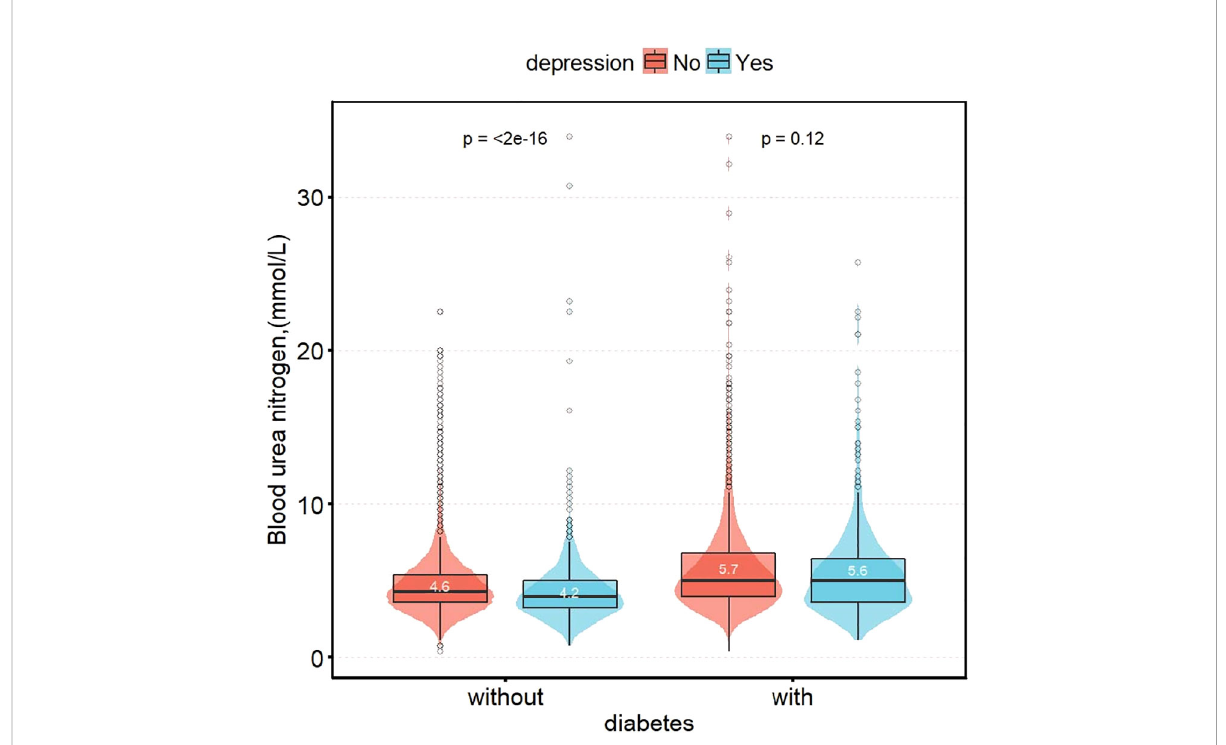
FIGURE 2 Distribution of blood urea nitrogen in patients with depression group by status of diabetes.